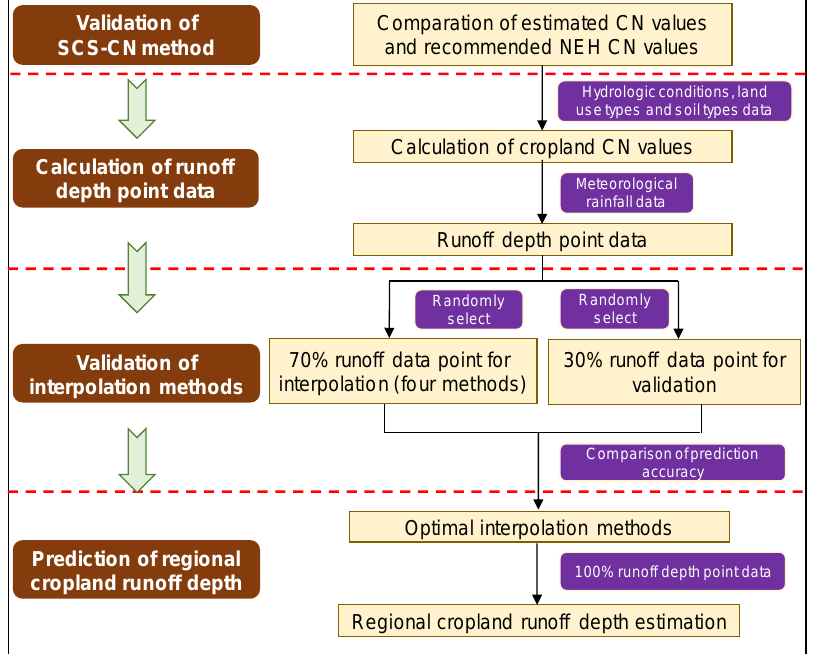
Figure 1. Framework for estimating national cropland runoff depth in China.